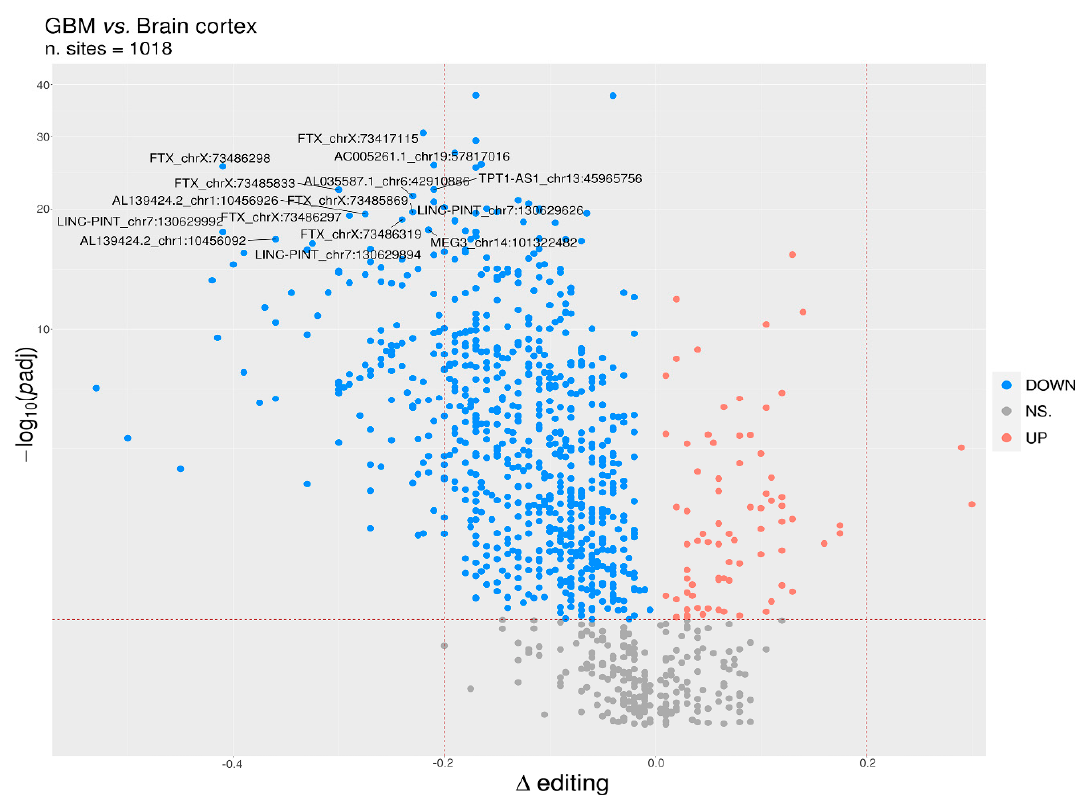
Figure 3. Identification of differentially edited sites in GBM. Volcano plot reporting the differentially edited sites between glioblastoma and normal cerebral cortex. The horizontal dotted line marks a multiple test-corrected level of significance ( padj < 0.05, Mann–Whitney with Benjamini–Hochberg correction). Y -axis was reported in a “log1p” transformed scale. The vertical dotted lines indicate a Delta editing of 20% (0.2) and − 20% ( − 0.2). Red, blue, and gray points indicate, respectively, over-edited (UP) sites, under-edited (DOWN) sites, and non-significative sites (NS.).